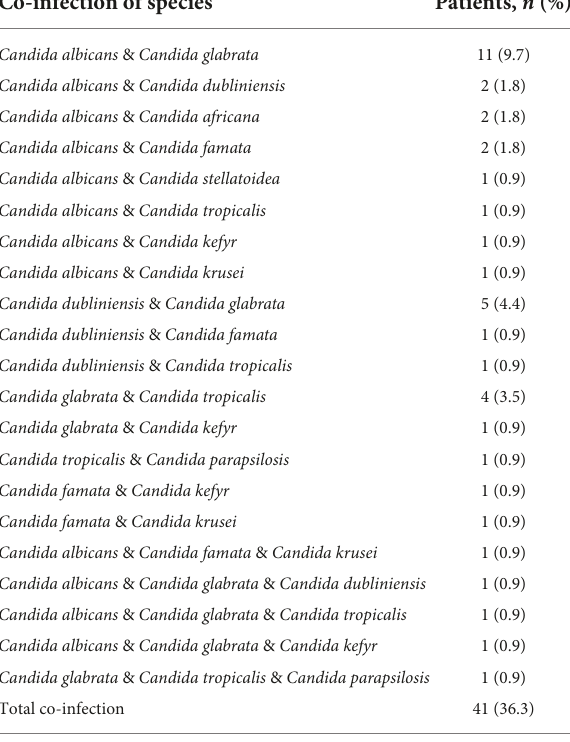
TABLE 2 Distribution of co-infection with different Candida species in 113 patients with OC. Co-infection of species Patients, n